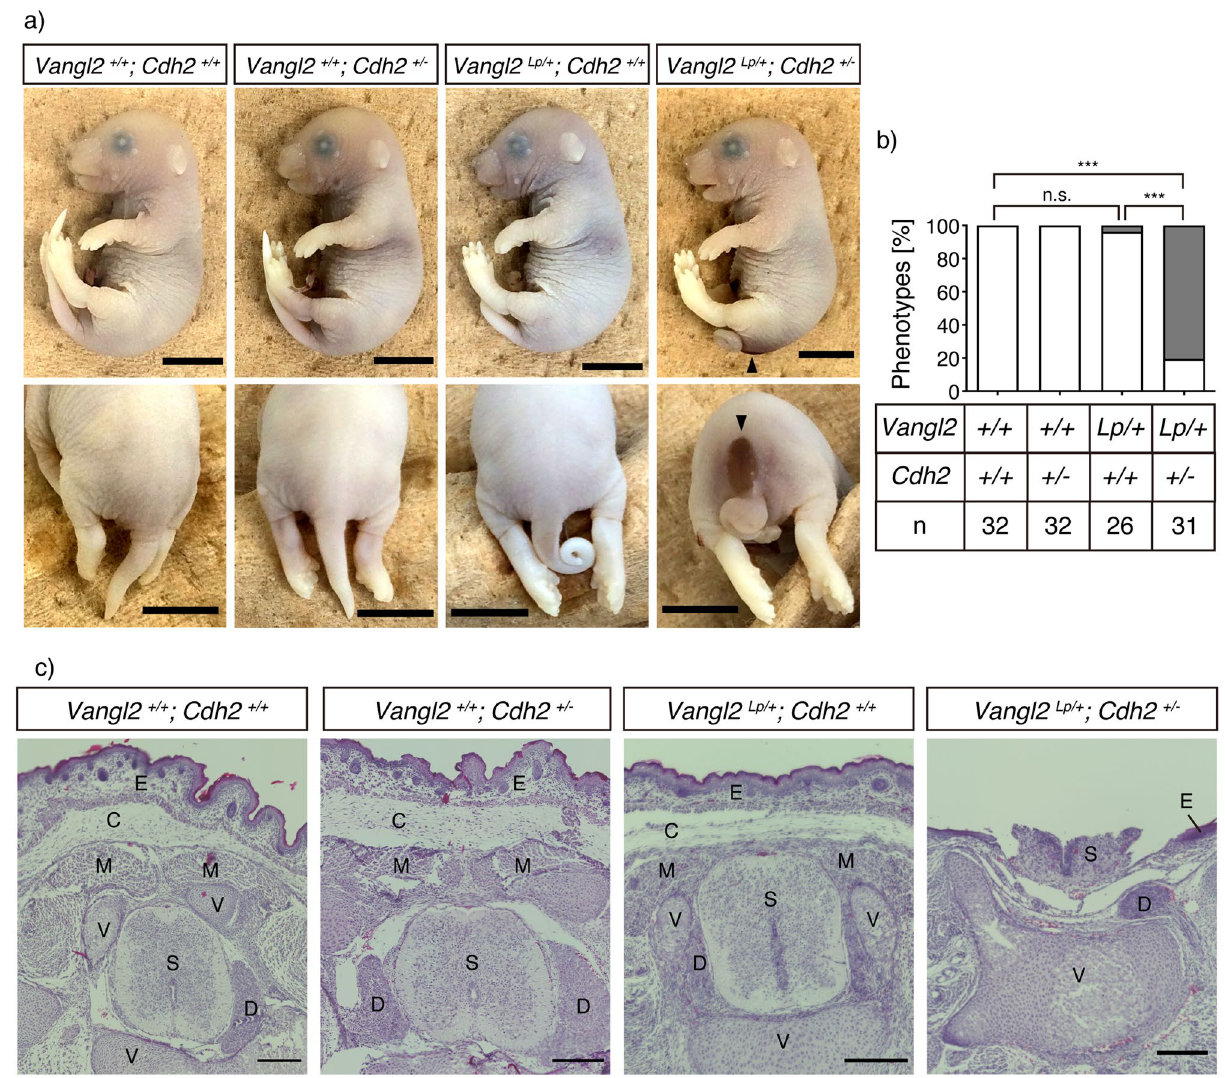
Figure 3. Genetic interaction between Vangl2 and Cdh2 in neural tube closure. ( a ) E18.5 embryos with the indicated genotypes are presented. The Vangl2 Lp/ + ; Cdh2 + /- mice (the rightmost panels), exhibited an open neural tube phenotype similar to the human myelomeningocele. The arrowheads indicate the neural tube defects (NTDs). ( b ) Bar graphs showing the ratio of the embryos born with (grey) or without (white) the NTDs. The number of mice counted for each genotype is indicated below the bar graph. ( c ) Hematoxylin– eosin staining of the caudal portion of coronally sectioned E18.5 embryos. E epidermis, C connective tissue, M muscle, V vertebra, S spinal cord, D dorsal root ganglia. Scale bars: 0.5 mm in a, 200 μm in c. Significant differences between groups were calculated using Fisher’s exact test (*** P < 0.001). n.s.; not within the ± 10° range was slightly reduced ( Cdh2 heterozygous KO:64%, Lp heterozygous mutant: 65%) and that of the ± 10–30° range was increased ( Cdh2 heterozygous KO:37%, Lp heterozygous mutant: 33%) (Fig. 6c,d,g,h).